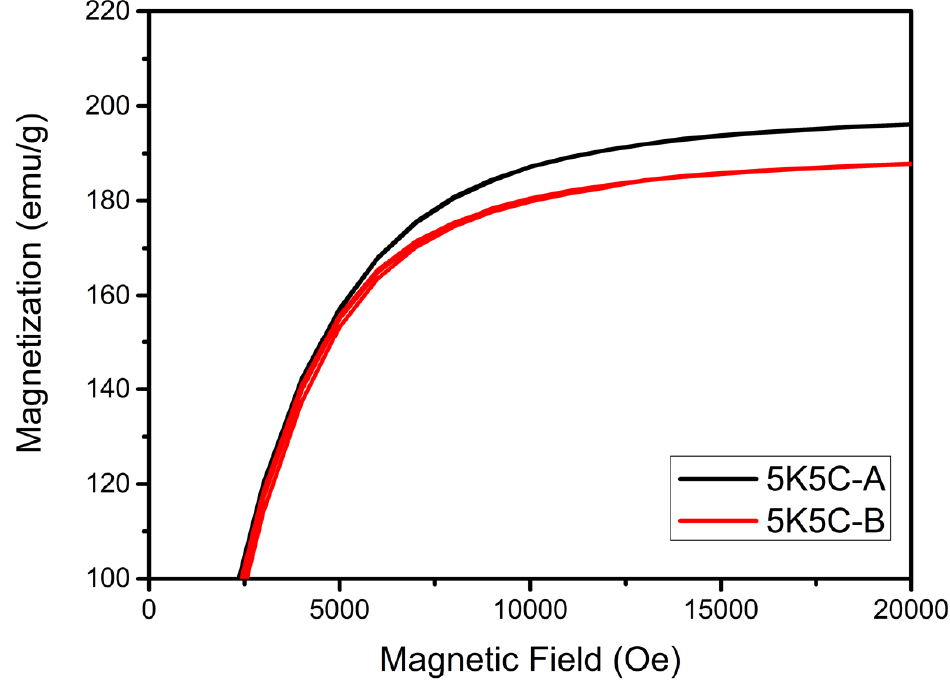
Figure 8. Effect of the heat-treatment procedure on the saturation magnetization of 5K5C (A: heat treatment after compaction; B: heat treatment before compaction).